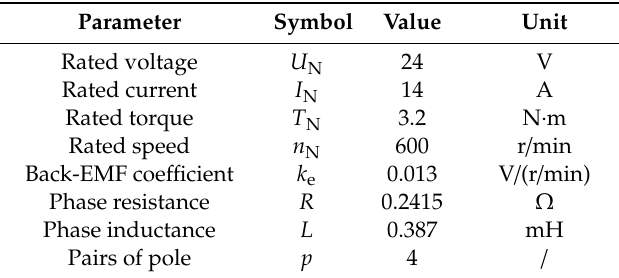
Table 1. Parameters of BLDCM.